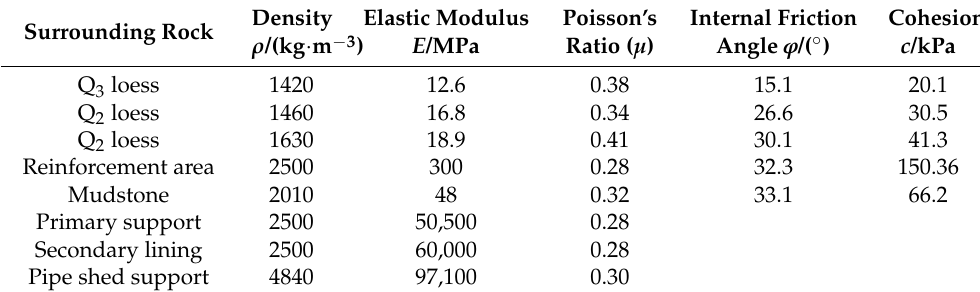
Table 1. Physical and mechanical parameters of surrounding rock and supporting structure. Surrounding